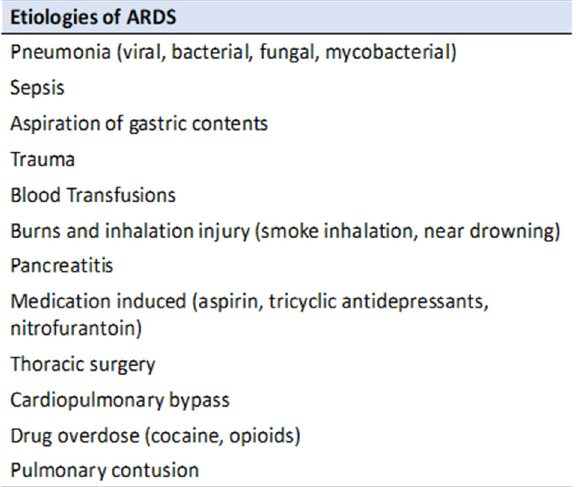
Figure 2. Common etiologies of ARDS.